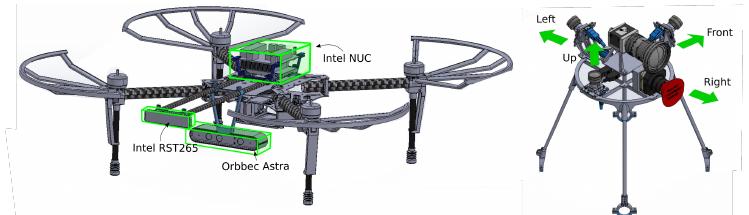
Figure 1. Aerial platform and inspection sensors schematics. Left : DJI Matrice 100 equipped with the Intel NUC unit, as well as the localization and mapping sensors. Right : Schematic showing the visual and thermal camera arrangement on the 3D-printed inspection sensor support. The left and front cameras are slightly tilted upward to avoid capturing the airframe in the